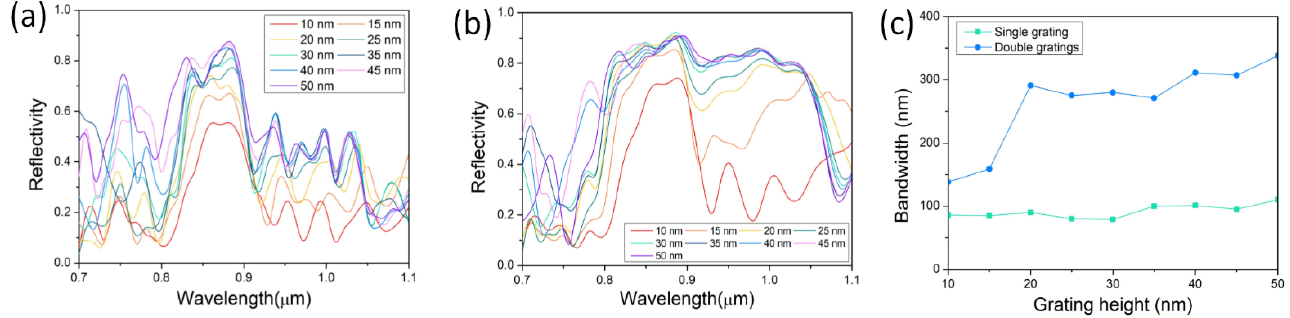
Figure 6. Reflective properties of gratings dependent on height of grating teeth. Reflective spectra of various height of grating teeth for nanowire ( a ) on single grating and ( b ) sandwiched in double gratings. ( c ) Comparison of reflectivity between nanowire on single grating and sandwiched in double gratings.